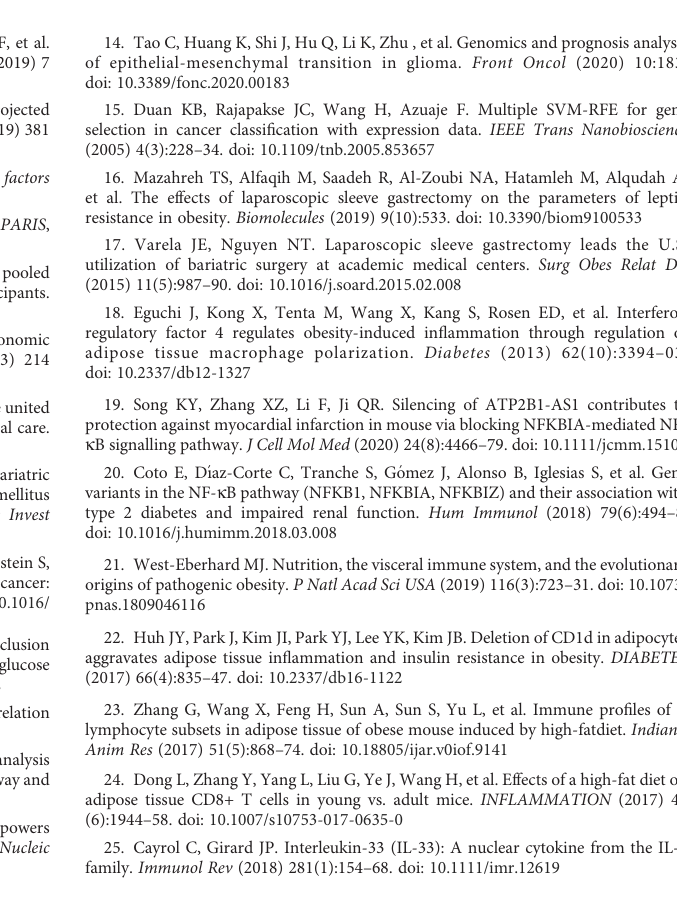
SUPPLEMENTARY TABLE 1 91 essential hub genes in the saddle brown modules. SUPPLEMENTARY TABLE 2 165 DE-mRNAs between obese patients before and after LSG treatment. SUPPLEMENTARY TABLE 3 Functional enrichment analysis of 165 DE-mRNAs.